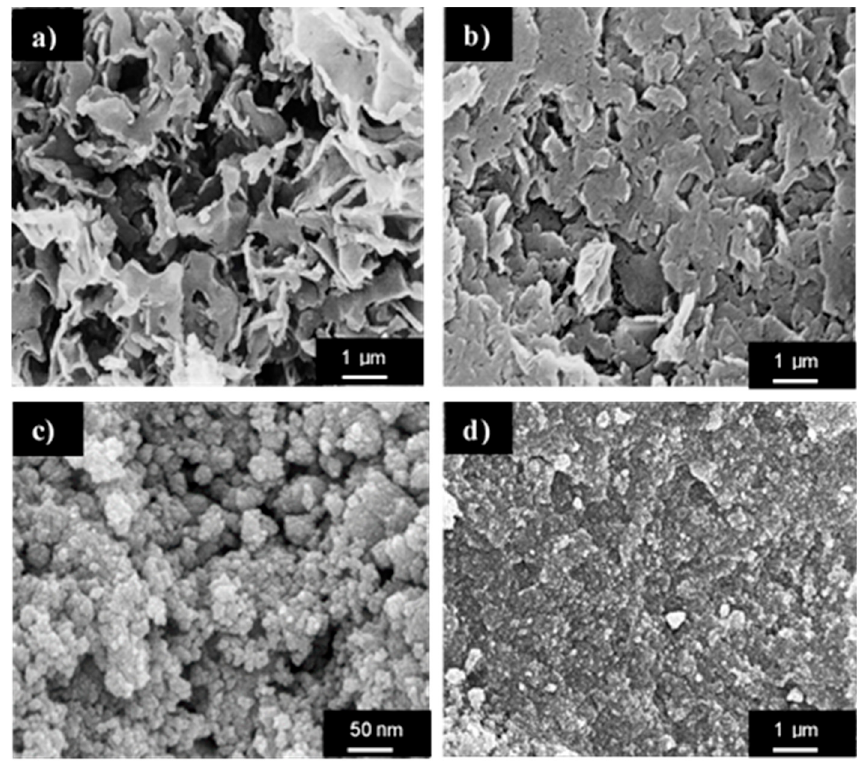
Figure 3. ( a ) SEM images of ( a ) bulk-CN, ( b ) CNS, ( c ) TiO 2 , and ( d ) 0.5CNS/TiO 2.